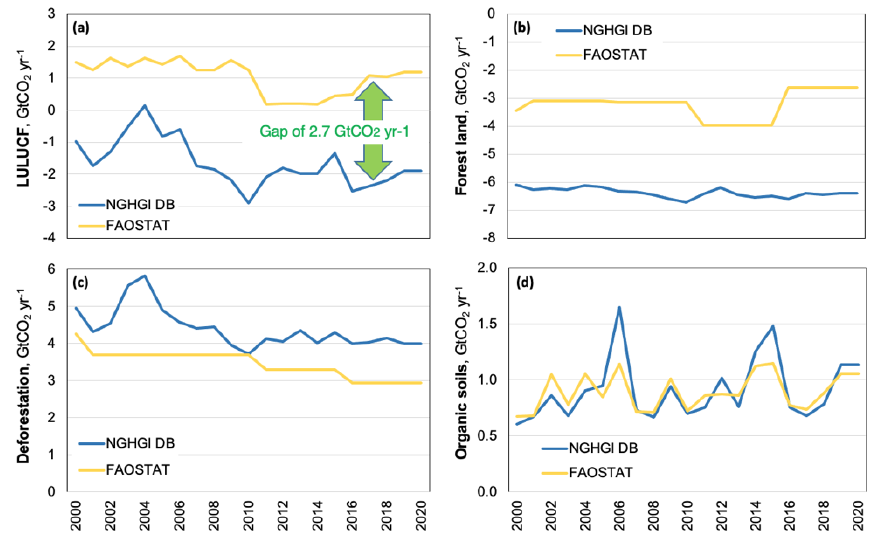
Figure 4. Global trend 2000–2020 of CO 2 fluxes from our NGHGI DB and FAOSTAT for LULUCF (a) , forest land ( b , including “forest land remaining forest land”, “land converted to forest land”, and harvest wood products), deforestation ( c , corresponding to net forest conversion in FAOSTAT), and organic soils ( d , including peat drainage and peat